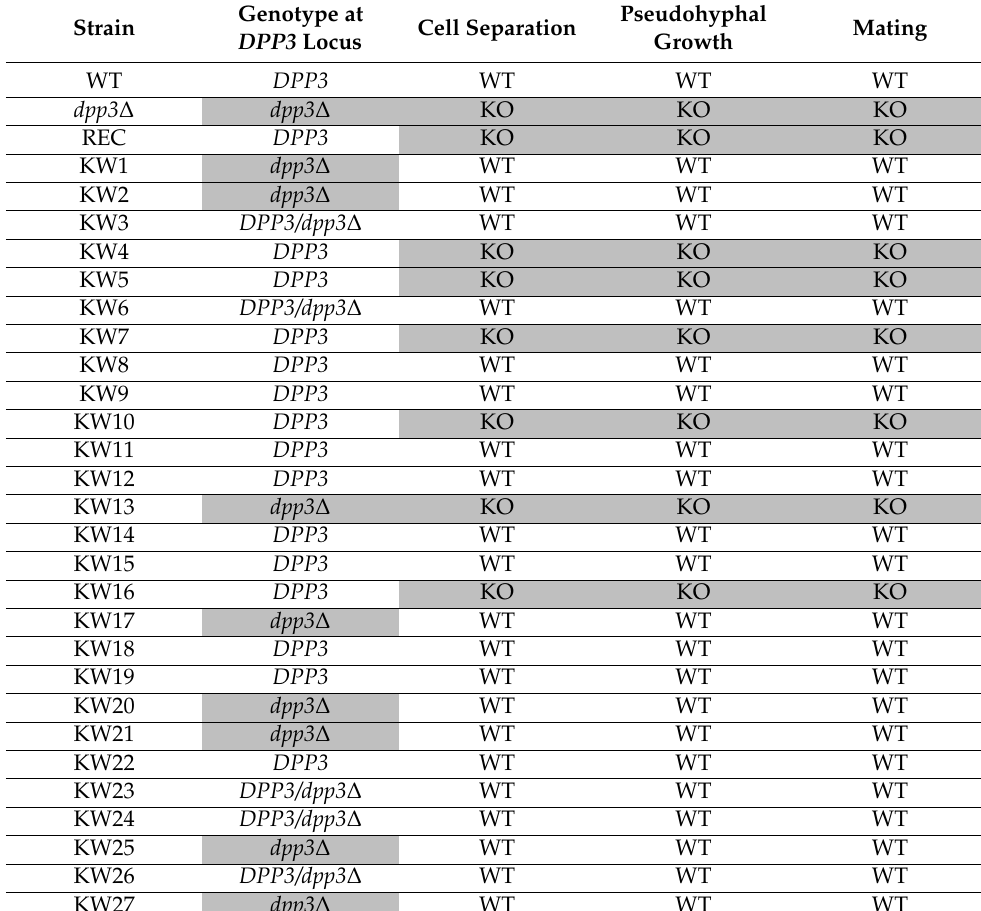
Table 2. Segregation analysis shows that dpp3 ∆ mutation is not responsible for the defective pheno- types in the dpp3 ∆ mutant. KW1-27: progeny of the cross between the dpp3 ∆ ura3 ∆ mutant ( ura3 ∆ , dpp3 ∆ ::0, med15 mut , MAT a ) and the leu2 ∆ strain ( leu2 ∆ , MAT α ). REC ( ura3 ∆ :: URA3, dpp3 ∆ :: DPP3, med15 mut , MAT a ) is a reconstituted strain carrying a WT copy of the DPP3 gene. For each strain, the genotype at the DPP3 locus was determined by PCR. The cytokinesis phenotype was observed using the microscope after 24 h in a 5 mL YPD liquid culture at 35 ◦ C, 215 rpm. The pseudohyphal growth phenotype was assessed by spotting 5 µ L of an overnight YPD culture of each strain (1 × 10 7 cells standard inoculum) on YCB agar plates. After 24 h of incubation at 30 ◦ C, microscopic images were taken and pseudohyphae length was measured. The mating phenotype was assessed by crossing each strain with reference strains 6936 ( MAT a ) and 5094 ( MAT α ) on YCB agar plates. After 72 h, mating cells were observed between slides and coverslips for typical mating structures. Progeny were assigned the “WT” or “KO” phenotype in reference to the phenotypes of the parental strains. Pseudohyphal Genotype at Mating Cell Separation Strain DPP3 Locus Growth WT DPP3